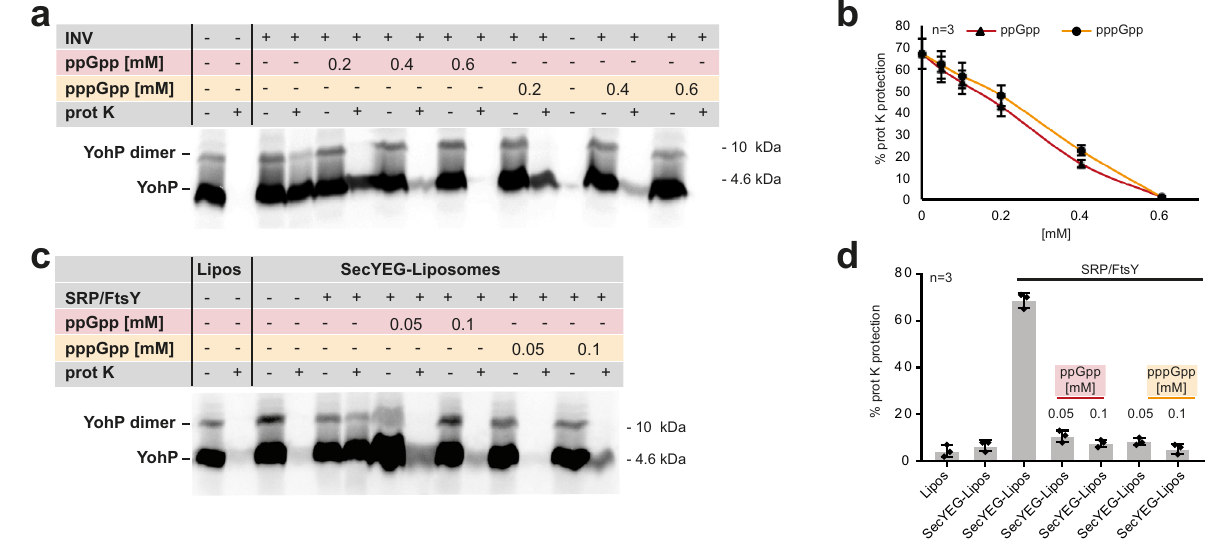
Fig. 1 Post-translational targeting of SRP substrate YohP is inhibited by (p)ppGpp. a YohP was in vitro synthesized using a puri fi ed coupled transcription/translation system (CTF system) and translation was terminated by the addition of chloramphenicol (35 mg mL − 1 ). Samples were then centrifuged for removing ribosomes and aggregates and the supernatant was incubated with INV (inner membrane vesicles) or INV-buffer for 10 min in the presence of 10 µ M GTP. Where indicated, ppGpp or pppGpp were added together with INV. Subsequently, one half of the sample was directly TCA precipitated, while the other half was fi rst treated with proteinase K (prot K) before TCA precipitation. Samples were then separated by SDS-PAGE and analyzed by autoradiography. b Quanti fi cation of three independent experiments as described in a and the mean values (±SD) are shown. c As in a , but insertion was analyzed in the presence of liposomes of reconstituted SecYEG-proteoliposomes. Liposomes were generated from E. coli phospholipids and contained 70% PE, 25% PG and 5% CL, and proteoliposomes contained 100 ng µ L − 1 SecYEG complex. When indicated, insertion was performed in the presence of absence of puri fi ed SRP/FtsY (20 ng µ L − 1 , each) and at the indicated (p)ppGpp concentrations. Uncropped images are shown in the Supplementary Material (Supplementary Fig. 2). Samples were further processed as described in a . d Quanti fi cation of three independent experiments as described in c and the mean values (±SD) are